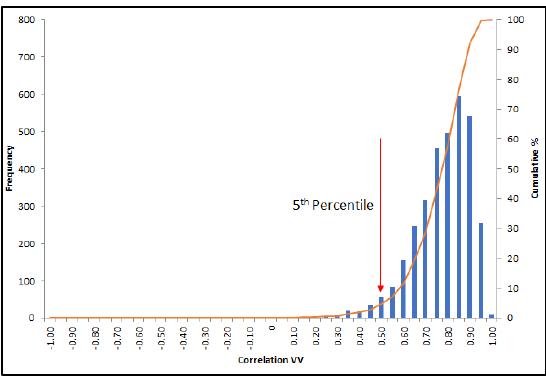
Figure 6. Training data VV correlation histogram.